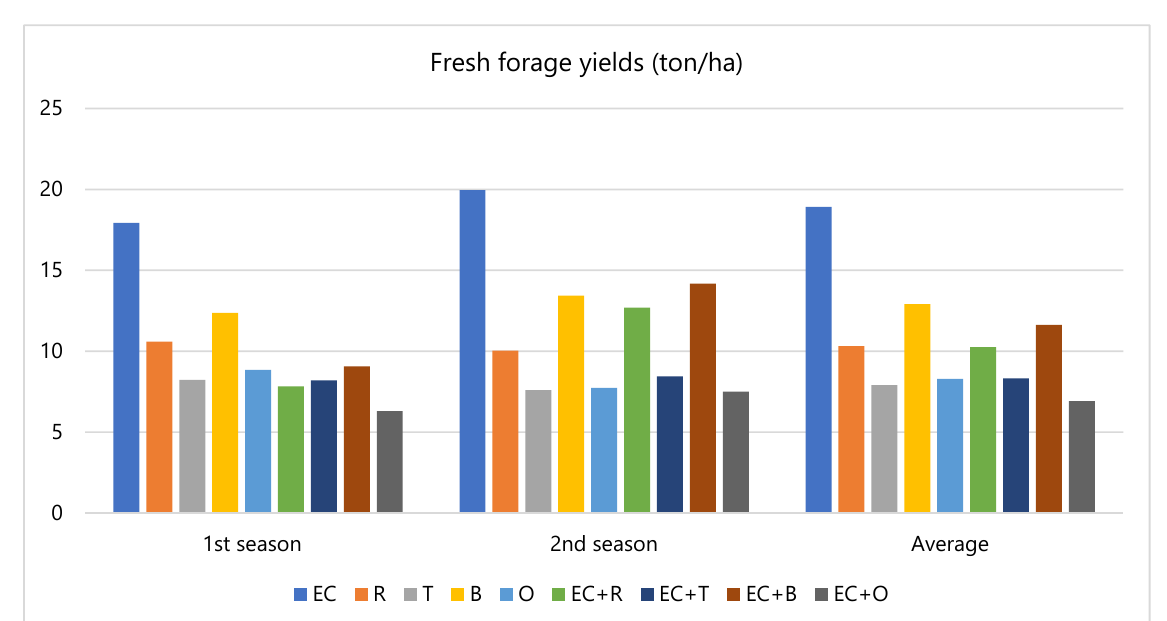
Figure 1. Means of fresh forage yields (ton/ha) from the different studied forages in each season of the study. EC = Egyptian clover monoculture, R = ryegrass monoculture, T = triticale monoculture, B = barley monoculture, O = oat monoculture, EC+R = Egyptian clover + ryegrass intercropping, EC+O = Egyptian clover + oat intercropping, EC+B = Egyptian clover + barley intercropping, and EC+T = Egyptian clover + triticale intercropping (L.S.D. season = 2.91, L.S.D. forages = 1.43, L.S.D. forage×season = 2.02).